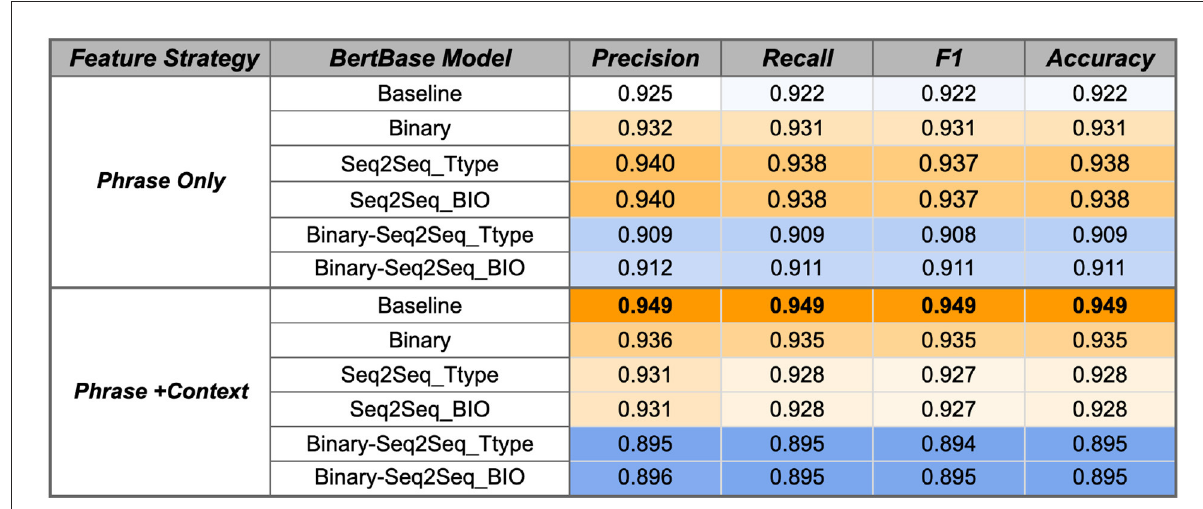
all scores in the